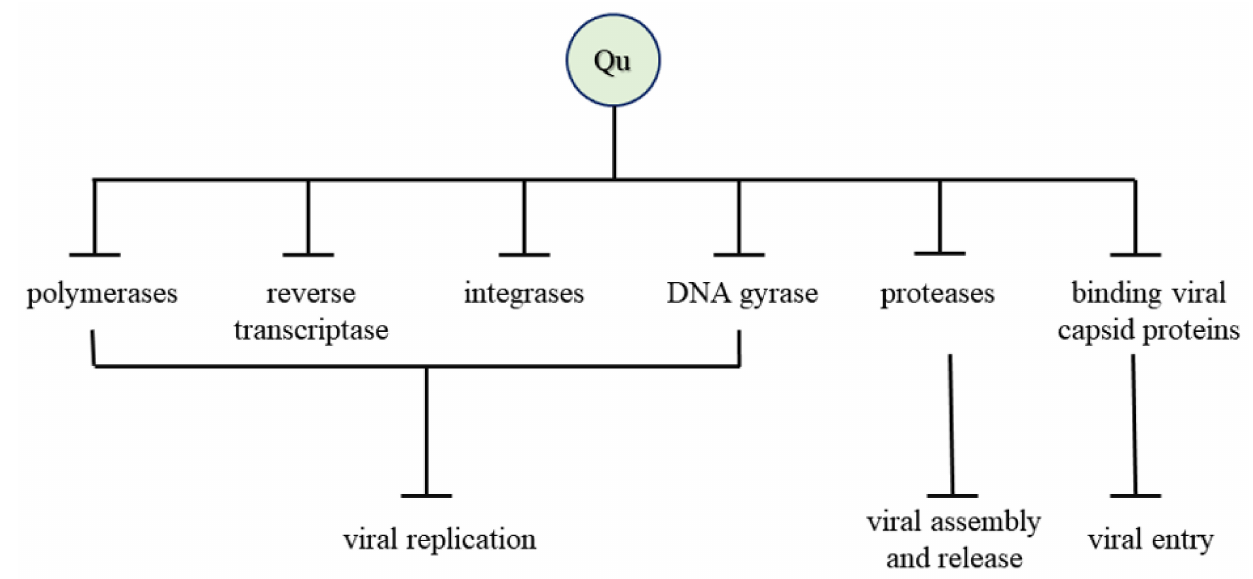
Figure 4. Antiviral mechanism of